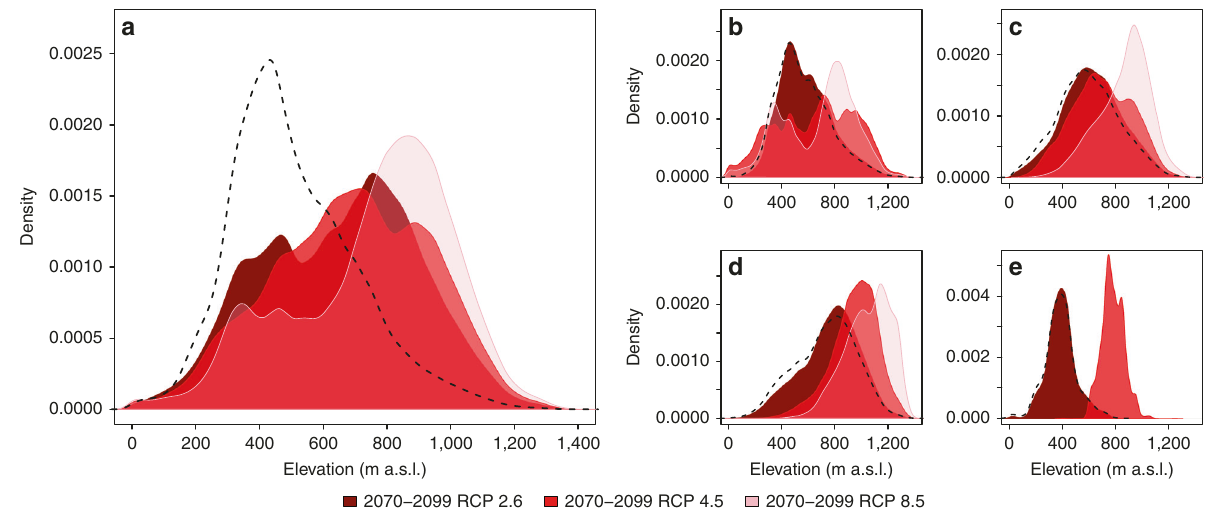
Fig. 6 Shifting elevational distribution of the northern Europe ’ s periglacial climate realm. The kernel density plots (bandwidth = 20) show the elevational distributions of the modelled LSP ( a combined spatial extent, b cryoturbation, c geli fl uction, d nivation and e permafrost mounding) under baseline 1981 – 2010 ( dashed black line ), 2070 – 2099 RCP 2.6, 2070 – 2099 RCP 4.5 and 2070 – 2099 RCP 8.5 climate conditions. For permafrost mounding ( e ), the kernel density estimation under scenario 2070 – 2099 RCP 8.5 was unfeasible due the low number of modelled occurrences. All distributions differed signi fi cantly ( t -test, p ≤ predictions were summed up to show the number of overlapping LSPs at given cells.